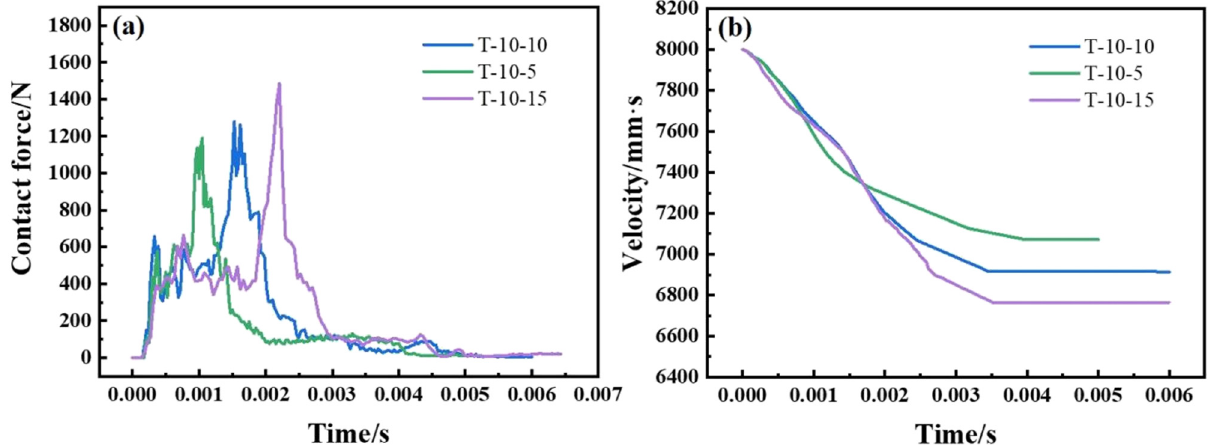
Figure 9: Comparison between contact force – time and velocity – time curves of T - 10 - 5, T - 10 - 10, and T - 10 - 15. ( a ) Contact force – time curves and ( b ) velocity – time curves.